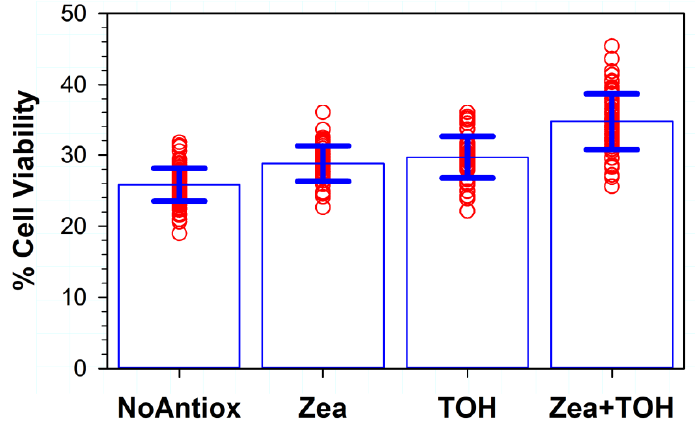
Figure 3. The effect of the pre-treatment of cells with lipophilic antioxidants vitamin E and/or zeaxanthin on the viability of ARPE-19 cells after 1 h exposure to visible light in the presence of liposomes containing 0.5 mM ATR. Cell viability was measured by MTT assay 24 h after the exposure. The symbols represent viability of cells in independent experiments, the heights of the bars indicate the means, while the error bars indicate SDs (N = 96 for experiments with no antioxidants (NoAntiox); N = 48 for experiments on cells supplemented with zeaxanthin (Zea) or α -tocopherol (TOH), N = 66 for experiments on cells supplemented with both zeaxanthin and α -tocopherol (Zea + TOH)).